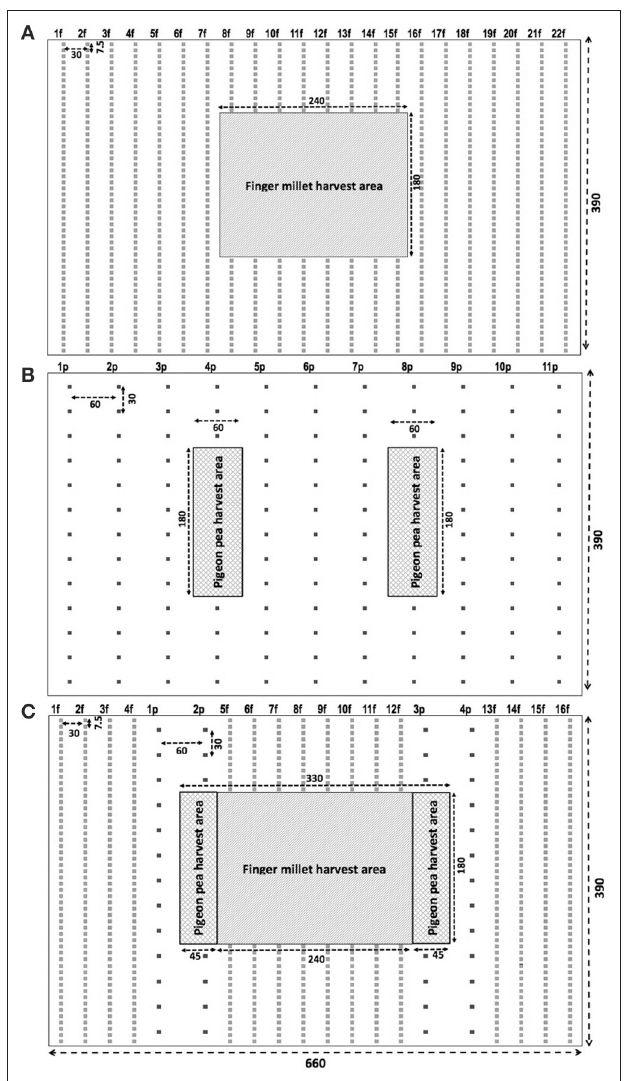
FIGURE 1 | Layout of a plot of (A) Finger millet monocropping (B) Pigeon pea monocropping (C) Finger millet + Pigeon pea intercropping. Plot dimensions are in centimeters. Finger millet harvest area and pigeon pea harvest area are shaded with their respective width and lengths. For clarity, finger millet rows are indicated in a series of 1f,2f,3f…and pigeon pea rows are indicated in a series of 1p,2p,3p.